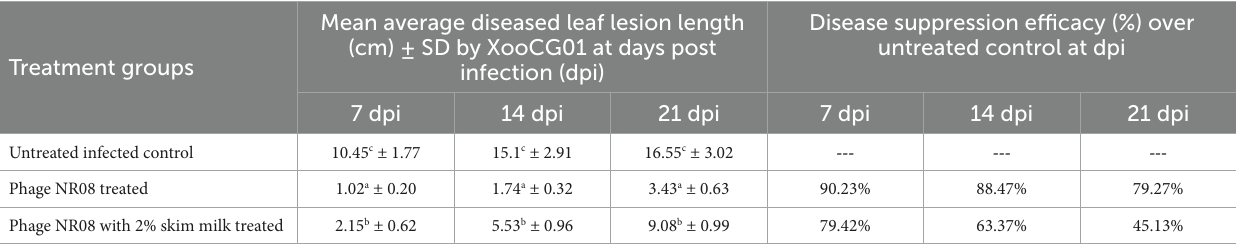
TABLE 4 Diseased mean leaf lesion length (cm) for the treatment groups of rice plants inoculated with NR08 phage preparation and BLB pathogen as observed up to 21 days post-infection.